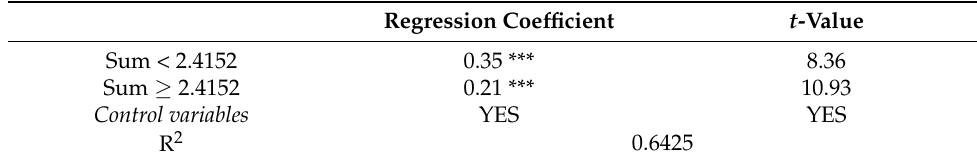
Table 7. Threshold effect test results.